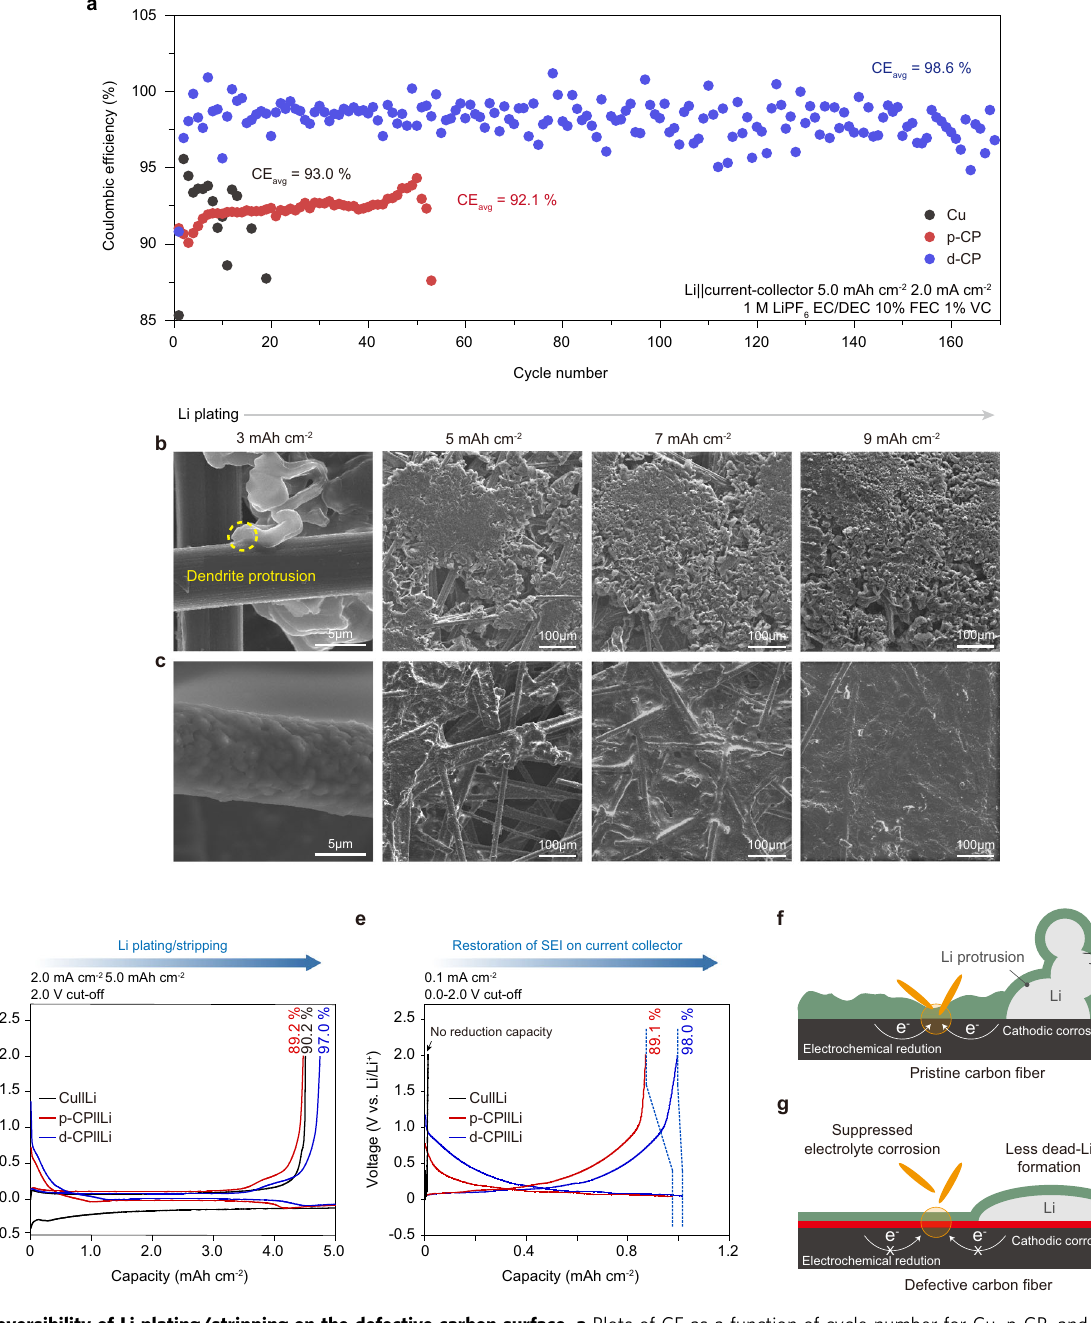
Fig. 6 Reversibility of Li plating/stripping on the defective carbon surface. a Plots of CE as a function of cycle number for Cu, p-CP, and d-CP current collectors in a half-cell con fi guration at a current density of 2.0 mA cm − 2 and a capacity of 5.0 mAh cm − 2 . b , c Li deposition morphologies for p-CP ( b ) and d-CP ( c ) at various plating capacities from 3.0 to 9.0 mAh cm − 2 . d , e Quanti fi cation of the irreversible capacity caused by Li metal plating/stripping and sequential restoration of damaged SEI on the current collector surface. SEI restoration was performed by galvanostatic cycling in the range of 0.0 and 2.0 V at a current density of 0.1 mA cm − 2 . f , g Schematics of the irreversible loss of Li and the electrolyte on the p-CP surface ( f ) and the proposed mechanism for preventing irreversibility on the d-CP surface ( g localized protrusion of Li at the surface of p-CP found at 3 mAh with the uniform nucleation of Li on MV defects, the d-CP cell cm − 2 triggered suffusion of the Li deposit on the top surface of showed the lowest deposition overpotential of 15 mV, which was p-CP at larger deposition capacities. This result indicated that the lower than the Cu cell value of 55 mV and p-CP cell value top Li deposition prevented the utilization of the structural of 28 mV. tridimensional porous network of p-CP (Supplementary Fig. 16k). The evolution of the Li morphology during Li electrodeposition at 1.0 mA cm − 2 with the carbonate electrolyte was observed for p-CP and d-CP. Figure 6b shows the SEM images of p-CP at various Li deposition capacities (3, 5, 7, 9 mAh cm − 2 ). The